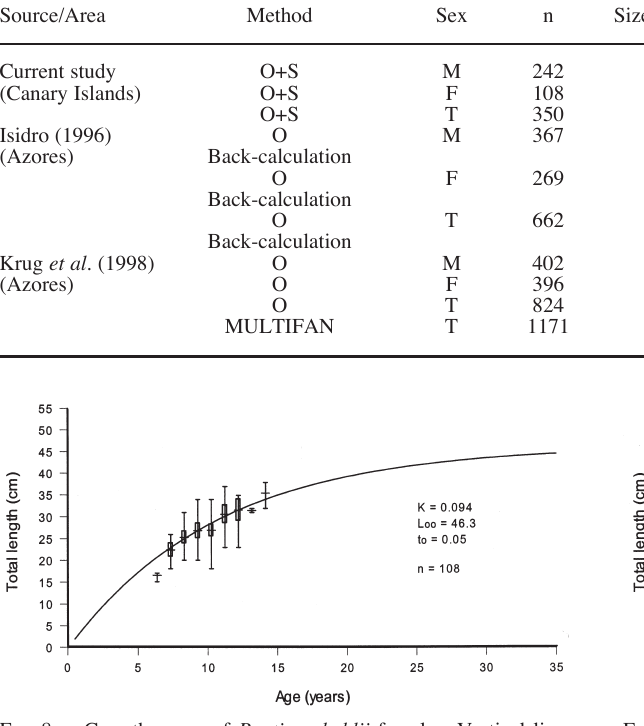
F IG . 9. – Growth curve of Pontinus kuhlii for males and females. Vertical lines represent length range observed and bars indicate mean +/-